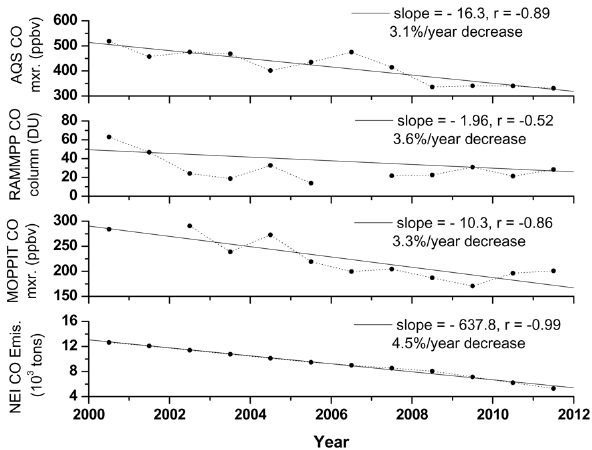
Fig. 11. The long-term trends of summertime AQS observations, RAMMPP measurements, MOPITT observations, and NEI emis- sions: (a) annual mean AQS CO mixing ratios; (b) annual mean RAMMPP morning column CO over western MD; (c) annual mean MOPITT near-surface CO mixing ratios; (d) annual NEI emissions. Lines show the results of linear regression